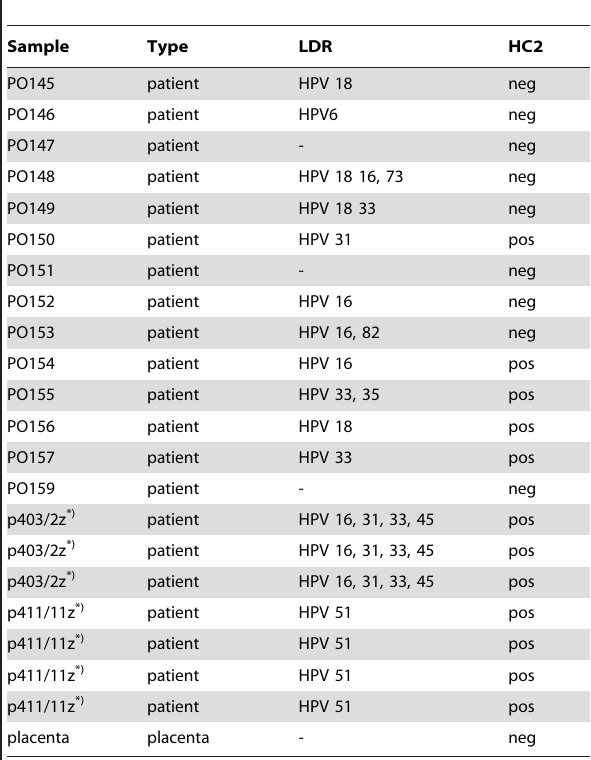
Table 1. Analysis of patient samples with LDR and Hybrid Capture 2.